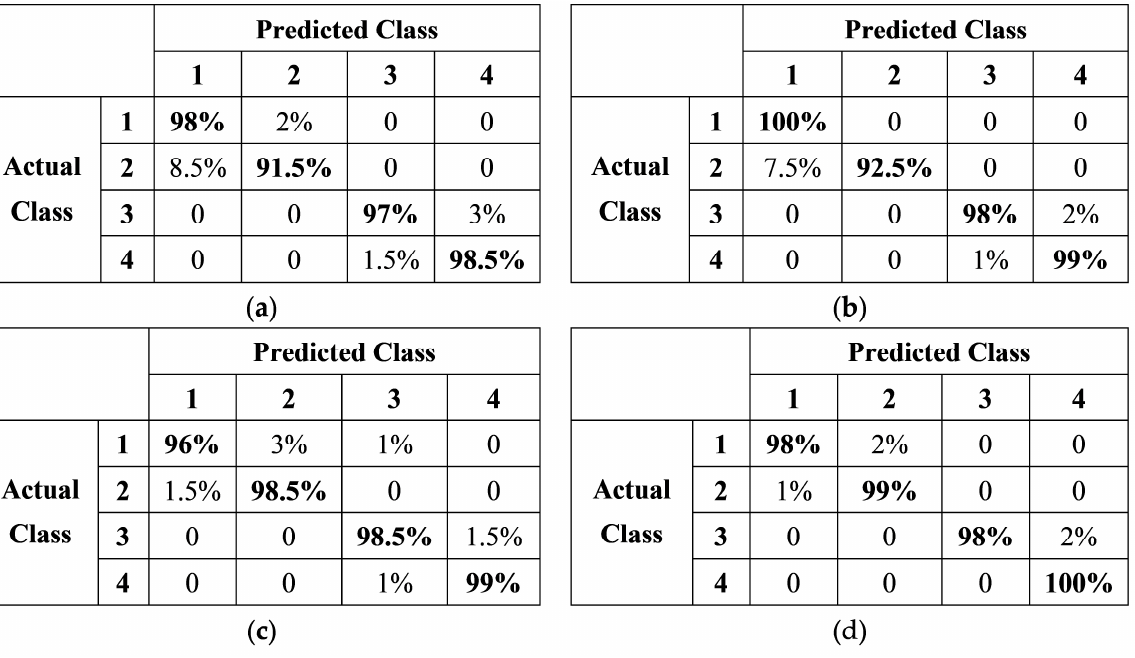
Figure 9. The confusion matrixes of ( a ) Model 1, ( b ) Model 2, ( c ) Model 3, and ( d ) Model 4. Table 3. The validation and testing performance of different models.